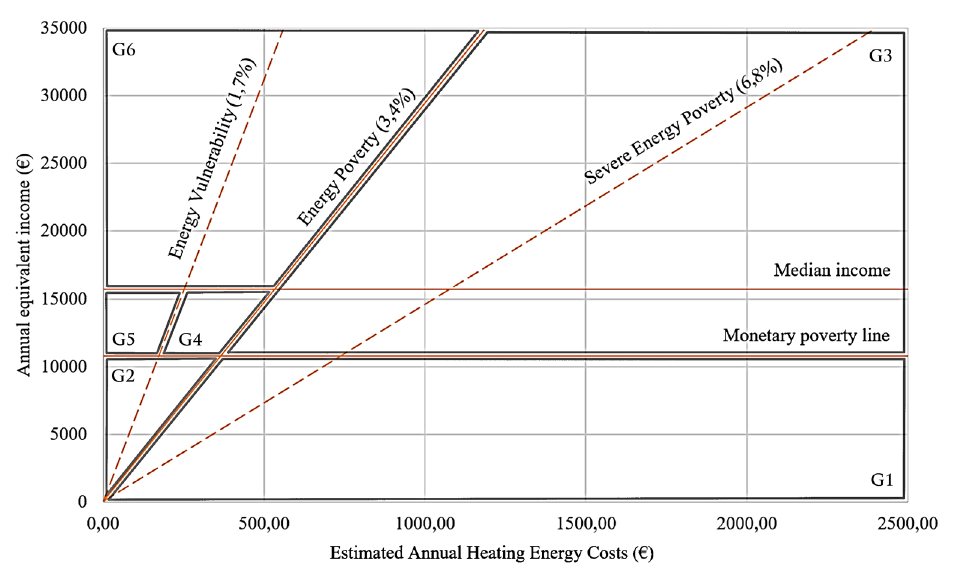
Fig. 2. Energy Poverty Assessment model for Bizkaia, based on the energy poverty methodology proposed by Sánchez-Guevara